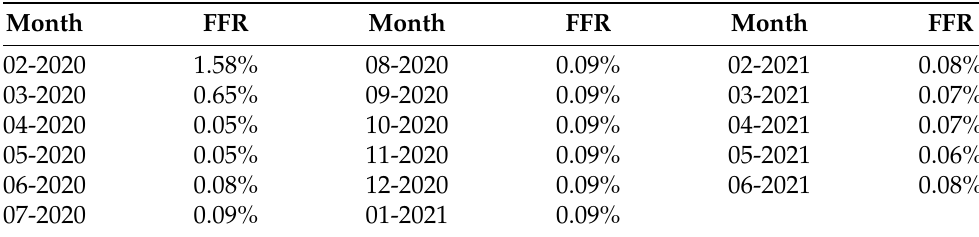
Figure 2. Federal Fund Rate time series: zoom on the COVID-19 outbreak. 1 July 2019–1 June 2021. Table 1. Federal Fund Rate. 1 February 2000–1 June